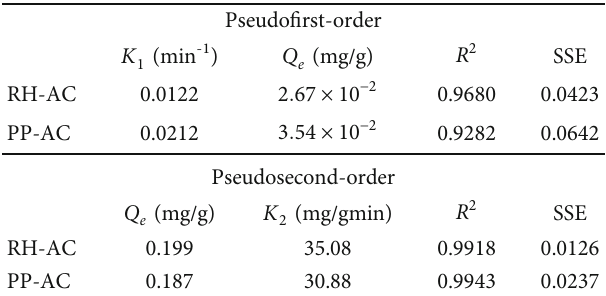
Table 3: The plot of pseudo fi rst-order and pseudosecond-order model